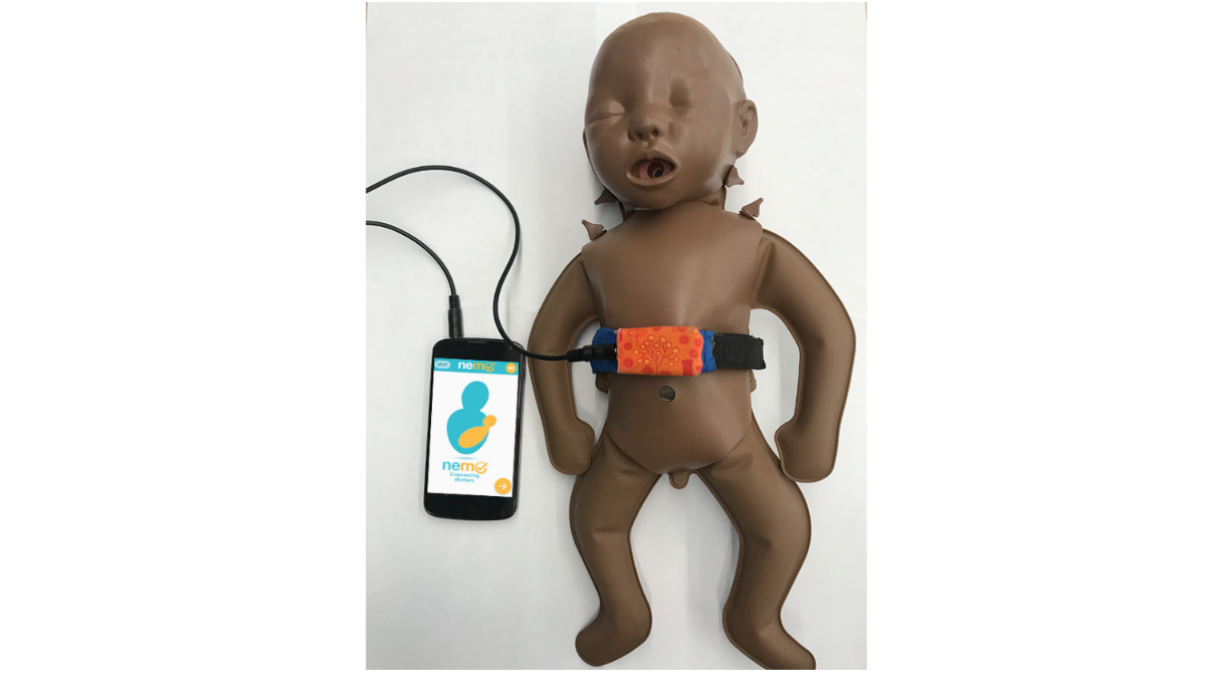
Figure 1. The NeMo (Neonatal Monitoring) band goes around the neonate’s abdomen to acquire respiratory rate and temperature data. The data is then transmitted via an audio cable and processed in the NeMo app, where it is then integrated with mothers' responses regarding qualitative danger signs to provide a recommendation on whether a mother should seek care for her